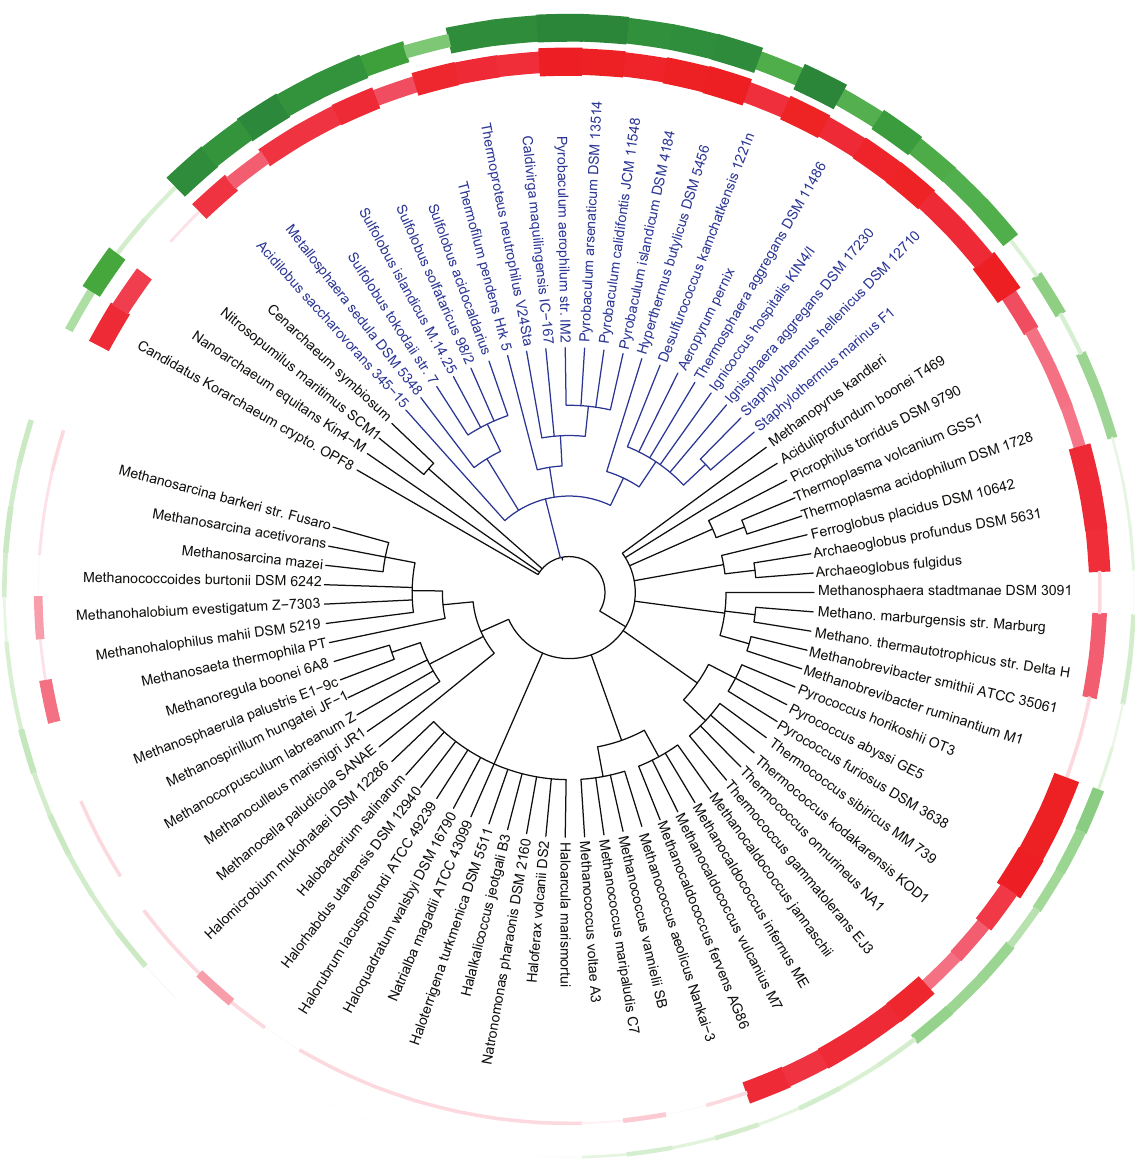
Figure 3: A phylogenetic tree showing the predicted abundance of disulfide bonding across the archaea. Each leaf of the tree is associated to specific values of the calculated disulfide abundance parameter ( f ) and optimal growth temperature, which are depicted in respective circular plots, green (outer ring) and red (inner ring). These values are represented by the properties of the curves, which vary in thickness (and darkness) in proportion to the corresponding quantity. A general correlation is seen between disulfide richness and growth temperature; specifically, disulfide bonding is dominant in the Crenarchaea (blue) and also notable in the subset of thermophilic Euryarchaea that are